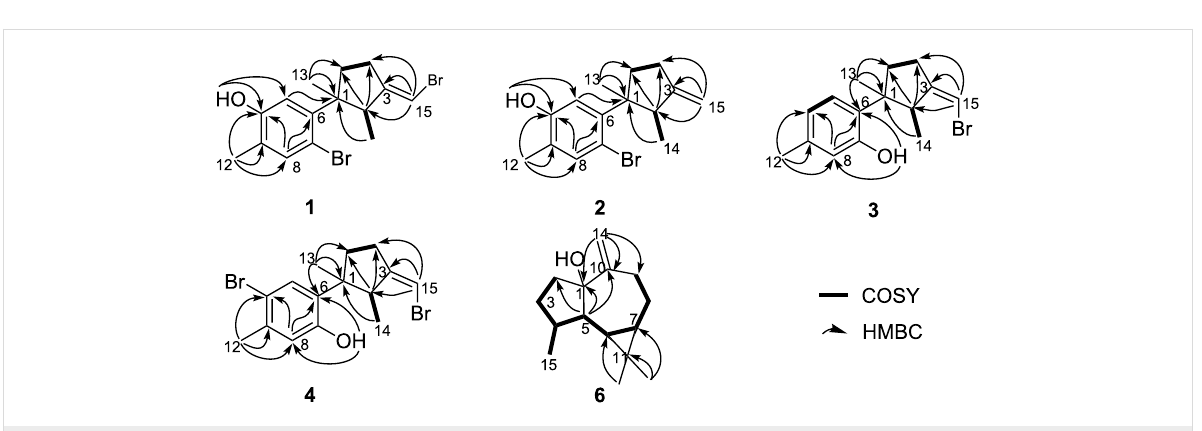
Figure 2: 1 H, 1 H COSY and key HMBC correlations of compounds 1 – 4 and 6 .